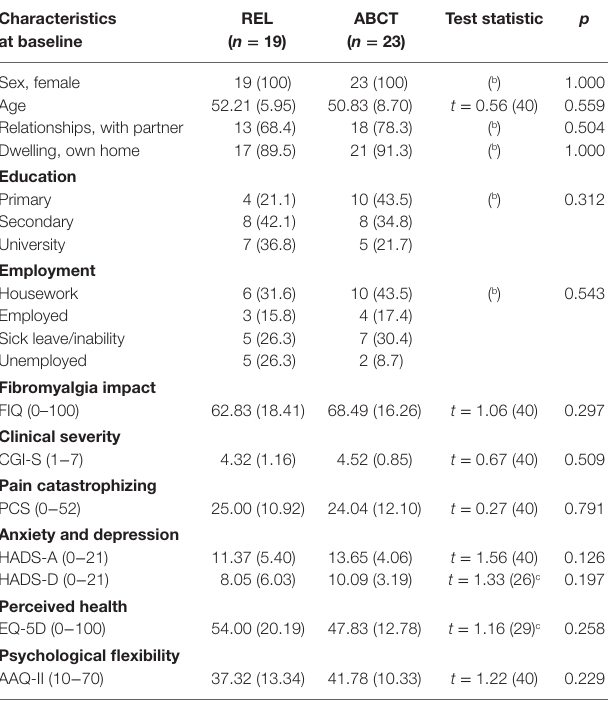
TaBle 2 | Baseline sociodemographic and clinical features of patients by group. a